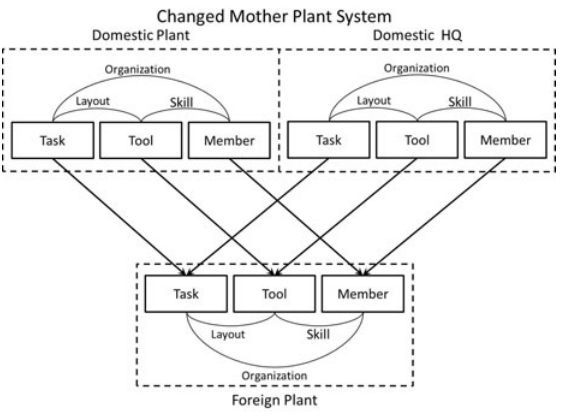
Figure 3. Knowledge transfer of changed mother plant